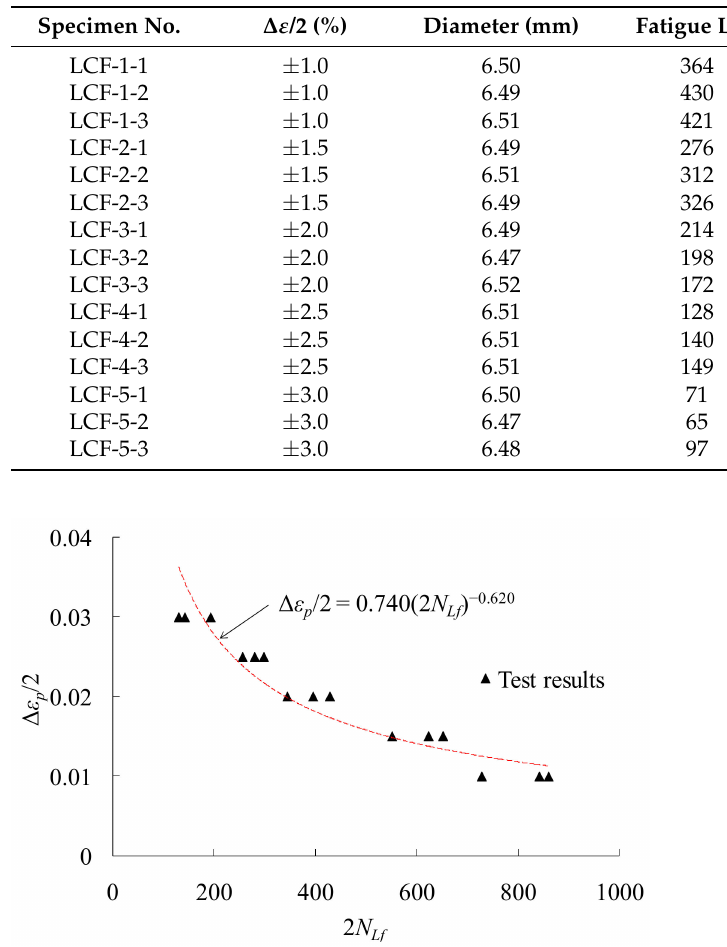
where D LCF is the fatigue damage index caused by LCF load, D LCF = 0 means the material is not damaged, while D LCF = 1 means LCF failure occurs. i represents the amplitude level of the strain load, n i represents the number of the applied load cycles with the i -th level amplitude, and N Lfi is the fatigue life corresponding to the i -th level amplitude strain load. The plastic component of the Coffin–Mansonrelation can also be expressed as